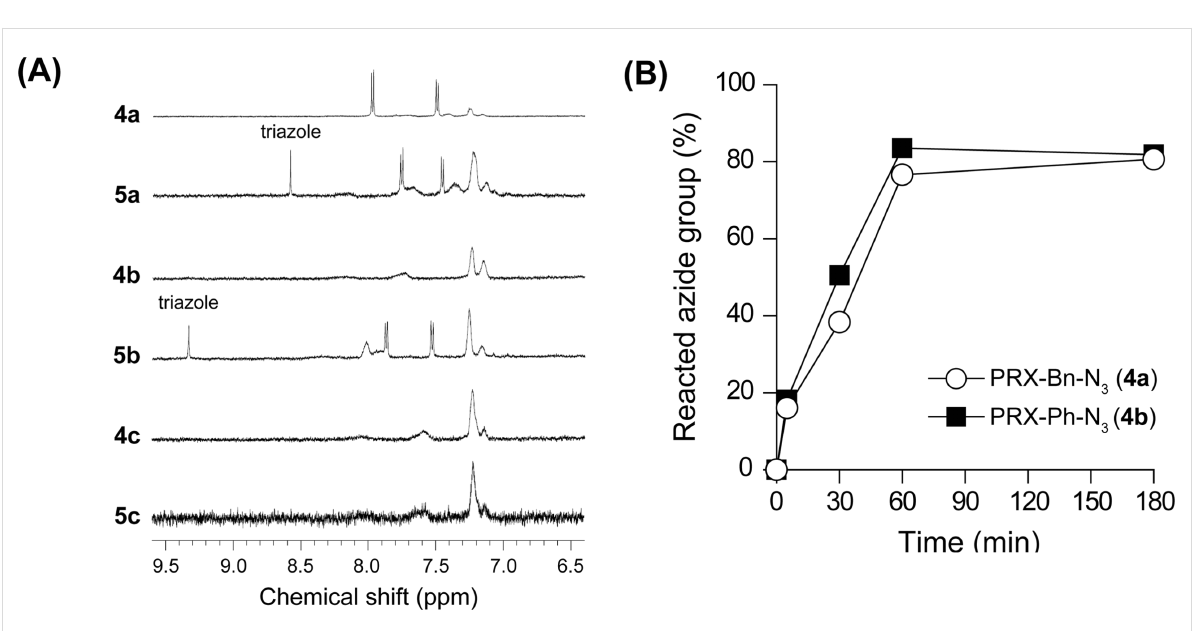
Figure 3: (A) 1 H NMR spectra of the PRXs before ( 4a , 4b , 4c ) and after copper-catalyzed click reactions with p -( tert -butyl)phenylacetylene for 60 min ( 5a , 5b , 5c ). Spectra were recorded in DMSO- d 6 . (B) Time-course of click reaction between the azide-terminated PRXs ( 4a : open circles, 4b : closed squares) and p -( tert